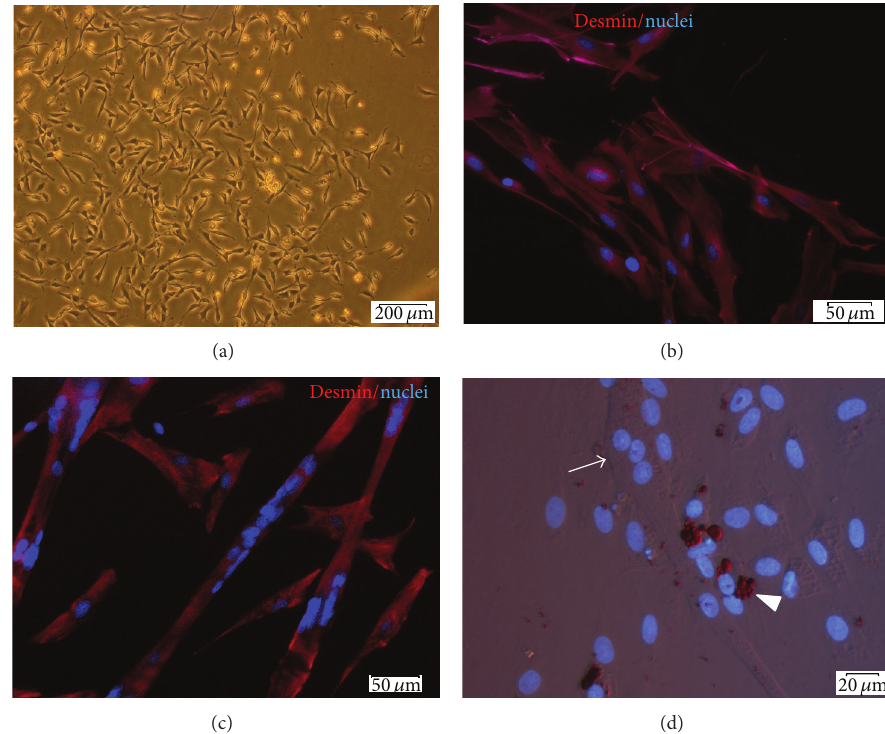
Figure 1: Identification of isolated muscle-derived cells. (a) The appearance of muscle-derived colony 6 days after isolation; (b and c) fluorescence microscopy. Desmin protein stained with Alexa 594 conjugated Ab (red) in undifferentiated MDCs (b) and in MDCs induced to myogenic differentiation for 3 days (c); (d) the presence of lipid accumulating cells within MDC population, red lipid droplets indicated with white arrowhead (Oil Red O staining), and cell nuclei stained with DAPI (blue). A multinucleated myotube can be observed in the same field of view (arrow). Scale bars in (a) 200 𝜇 m, (b and c) 50 𝜇 m, and (d) 20 𝜇